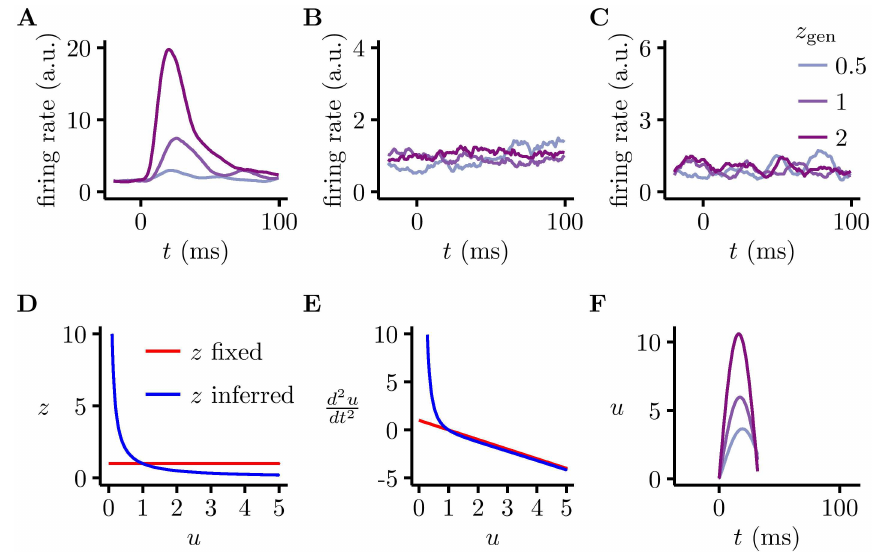
Fig 7. Large, contrast-dependent firing rate transients in the model. A-C. Transients (or lack thereof) at different contrast levels (colour) under the full dynamics( A ), using Langevindynamics( B ), and under the full dynamics when the value of z is fixed, z = z gen ( C ). Note different scales for firing rates in the three panels to better show the full range of firing rate fluctuations in each case. D. Dependence of the inferred value of contrast, z , on the currently inferred magnitude of basis function intensities, u , under the simplifieddynamics (blue). For reference,red shows the value of z when set to be fixed at z = z gen . E. There is asymmetry in € u as a function of u , aroundthe value of u = (cid:22) u = 1, in the simplifiedmodel when z is inferred (blue) but not when it is fixed (red). F. Transients predictedby the simplifieddynamics (Eq 9, with parametersas in Fig 6D, and initial conditions u (0) = 0.1 and _ u ð 0 Þ ¼ 0 ) are similar to transients under the full